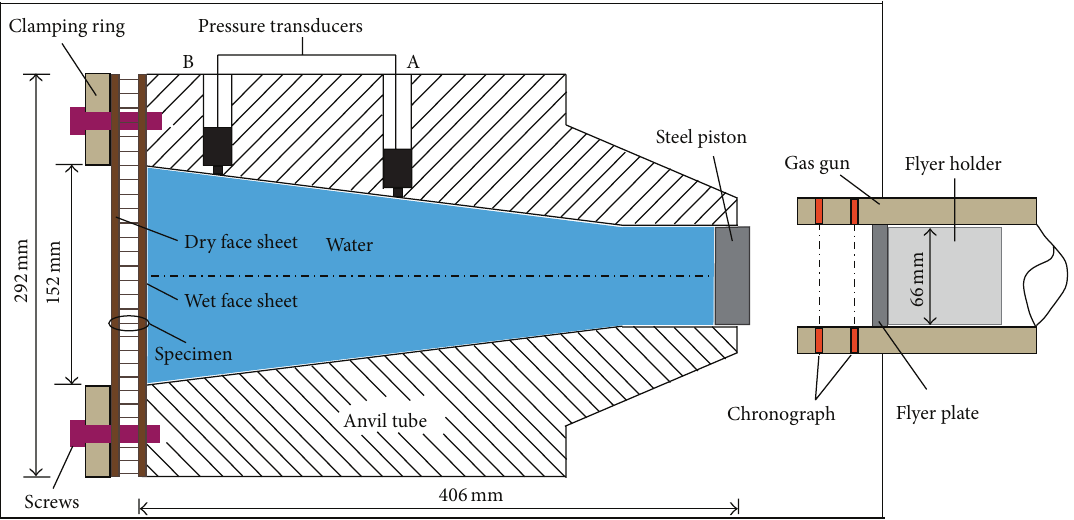
Figure 3: Schematic of water chamber with divergent